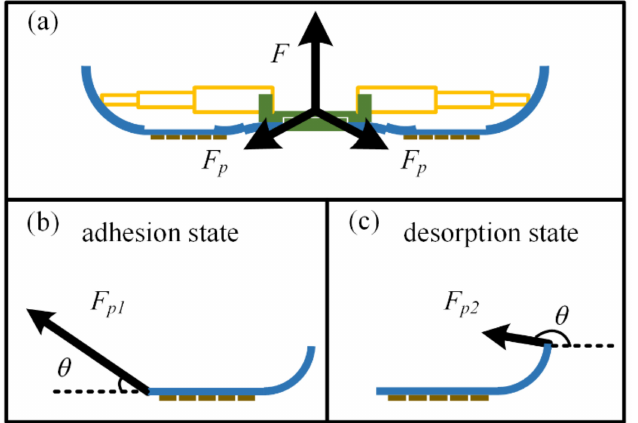
Figure 15. Toe force in different states: ( a ) When the foot is in the adhesion state, the contralateral toe forms a “Y” structure; ( b ) the force state of each toe when the foot is in the adhesion state; ( c ) the force state of each toe when the foot is in the desorption